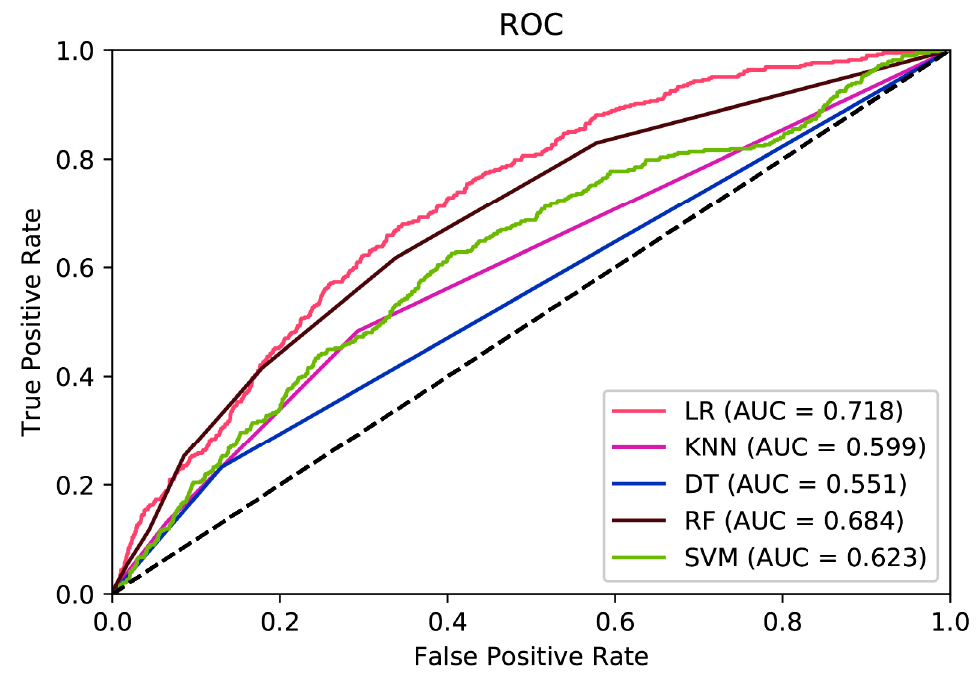
Figure 2. Receiver operating characteristic (ROC) curve of LR, KNN, DT, RF, and SVM models. LR—logistic regression; KNN—k-nearest neighbor; DT—decision trees; RF—random forests; SVM—support vector machines.